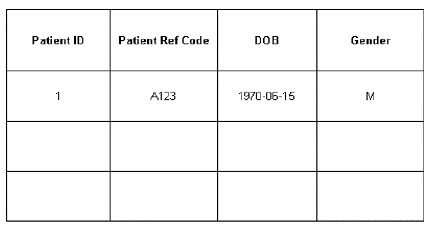
Figure 15. Patient table in a local database.